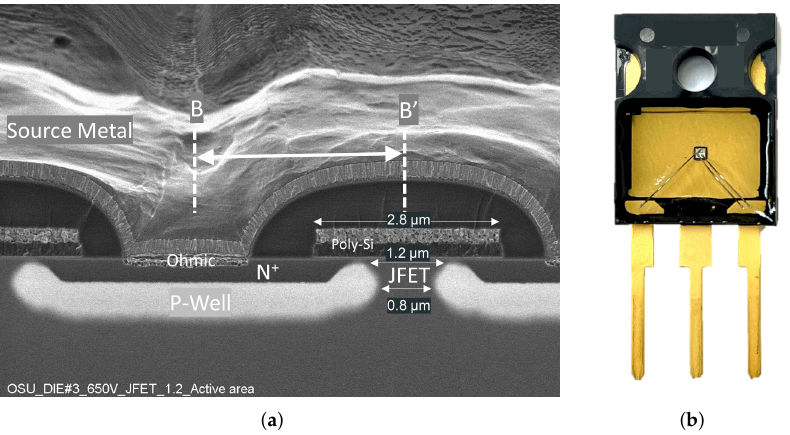
Figure 2. ( a ) Cross-sectional SEM image along B-B (cid:48) of the fabricated 650V SiC power MOSFETs with 1 W JFET = 0.6 µ m and ( b ) 650V SiC power MOSFET in a open-cavity TO-247 2